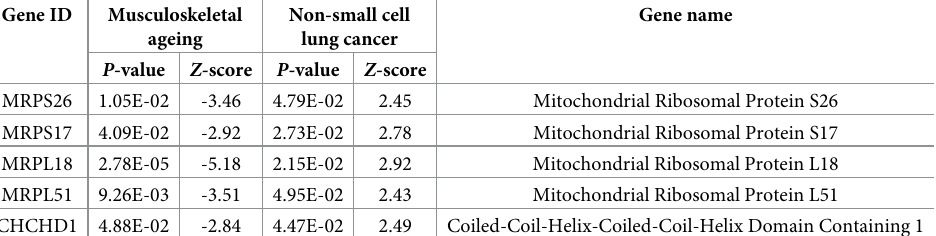
Table 2. The top five ranked and overlapping hub genes according to 11 topological algorithms in the protein- protein interaction networks of musculoskeletal ageing and non-small cell lung cancer differentially expressed